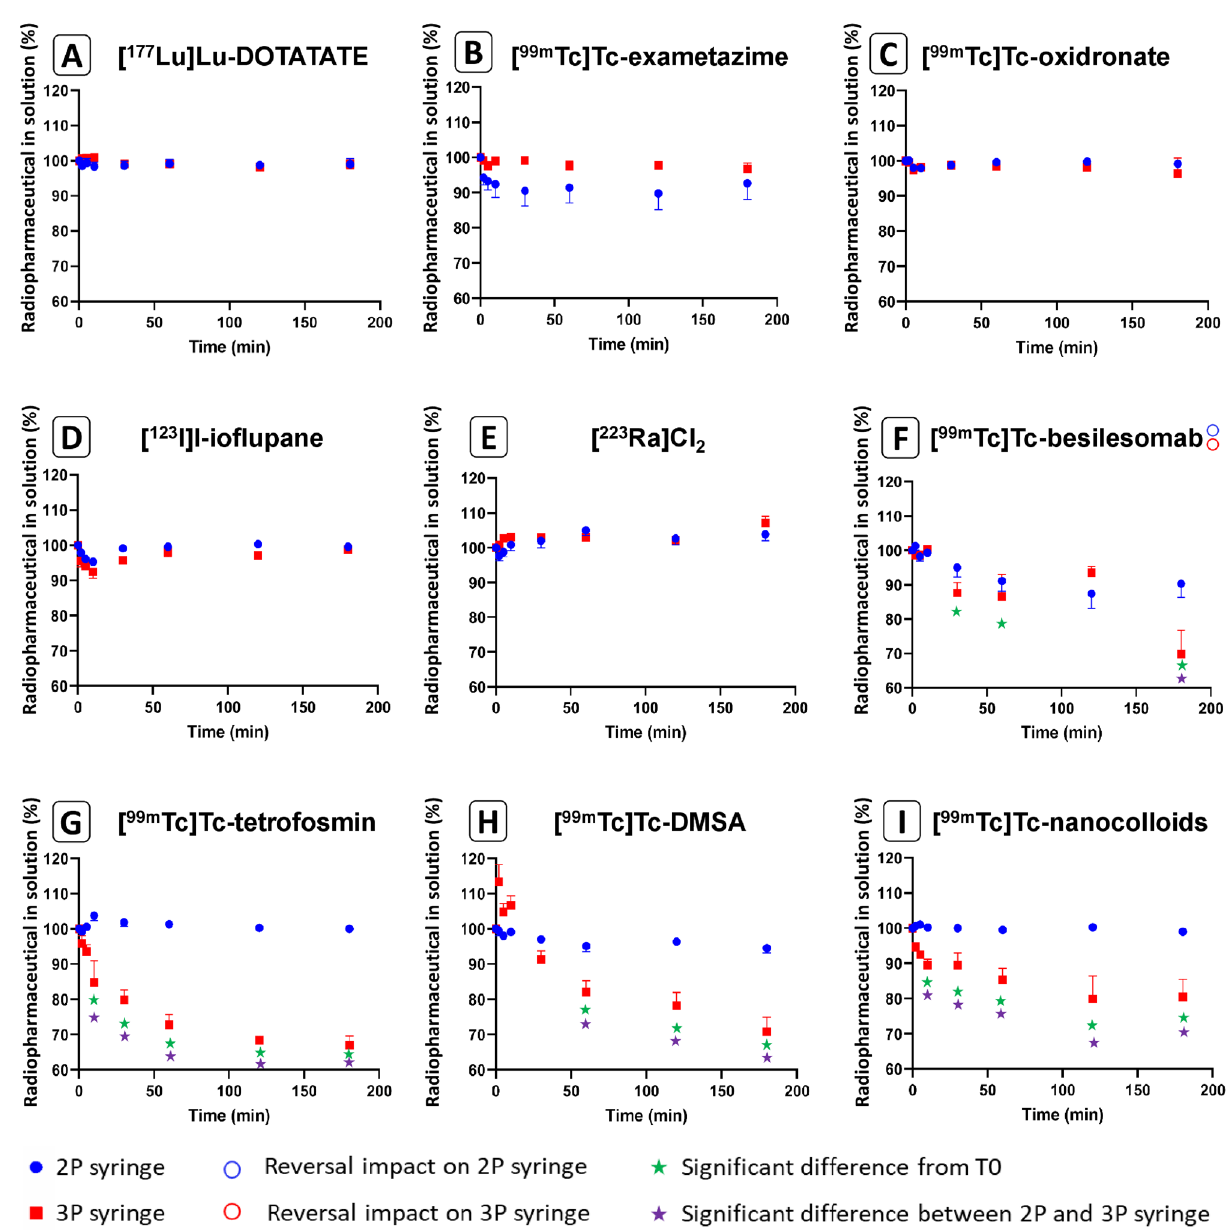
Figure 1. Kinetics of the radioactivity measured from the nine radiopharmaceuticals in 2 and 3-part